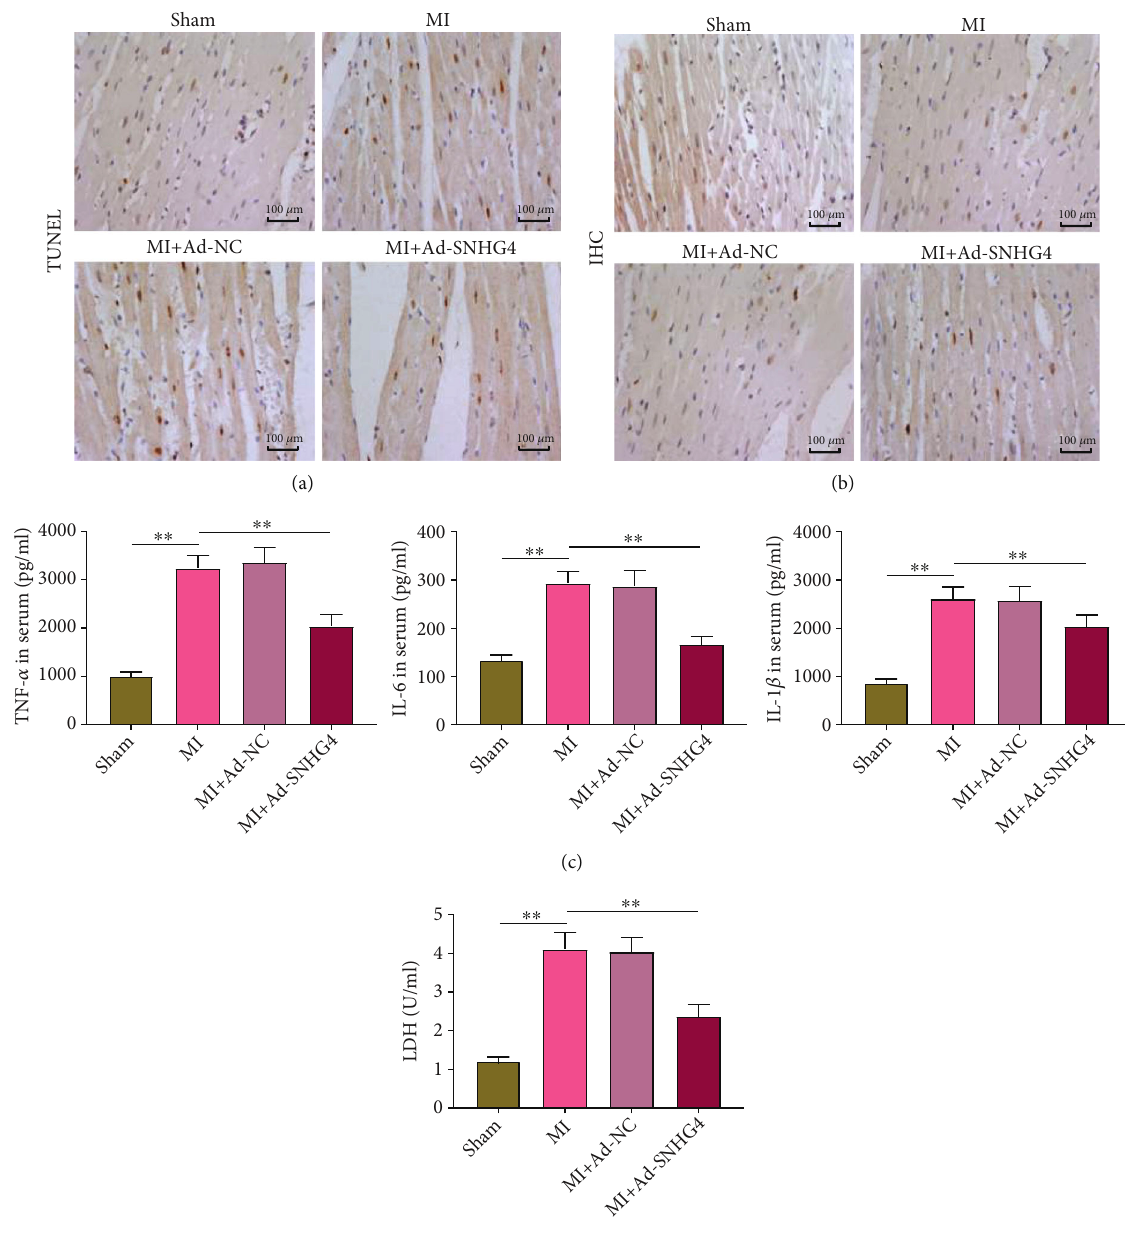
Figure 8: The e ff ects of SNHG4 overexpression on the apoptosis and in fl ammation of myocardial cells in MI rats. (a) The apoptotic cells were observed by TUNEL staining. (b) Ki67-positive cells were observed by IHC. (c) The serum levels of TNF- α , IL-6, and IL-1 β were measured by ELISA. (d) The serum level of LDH. ∗∗ P < 0 : 01